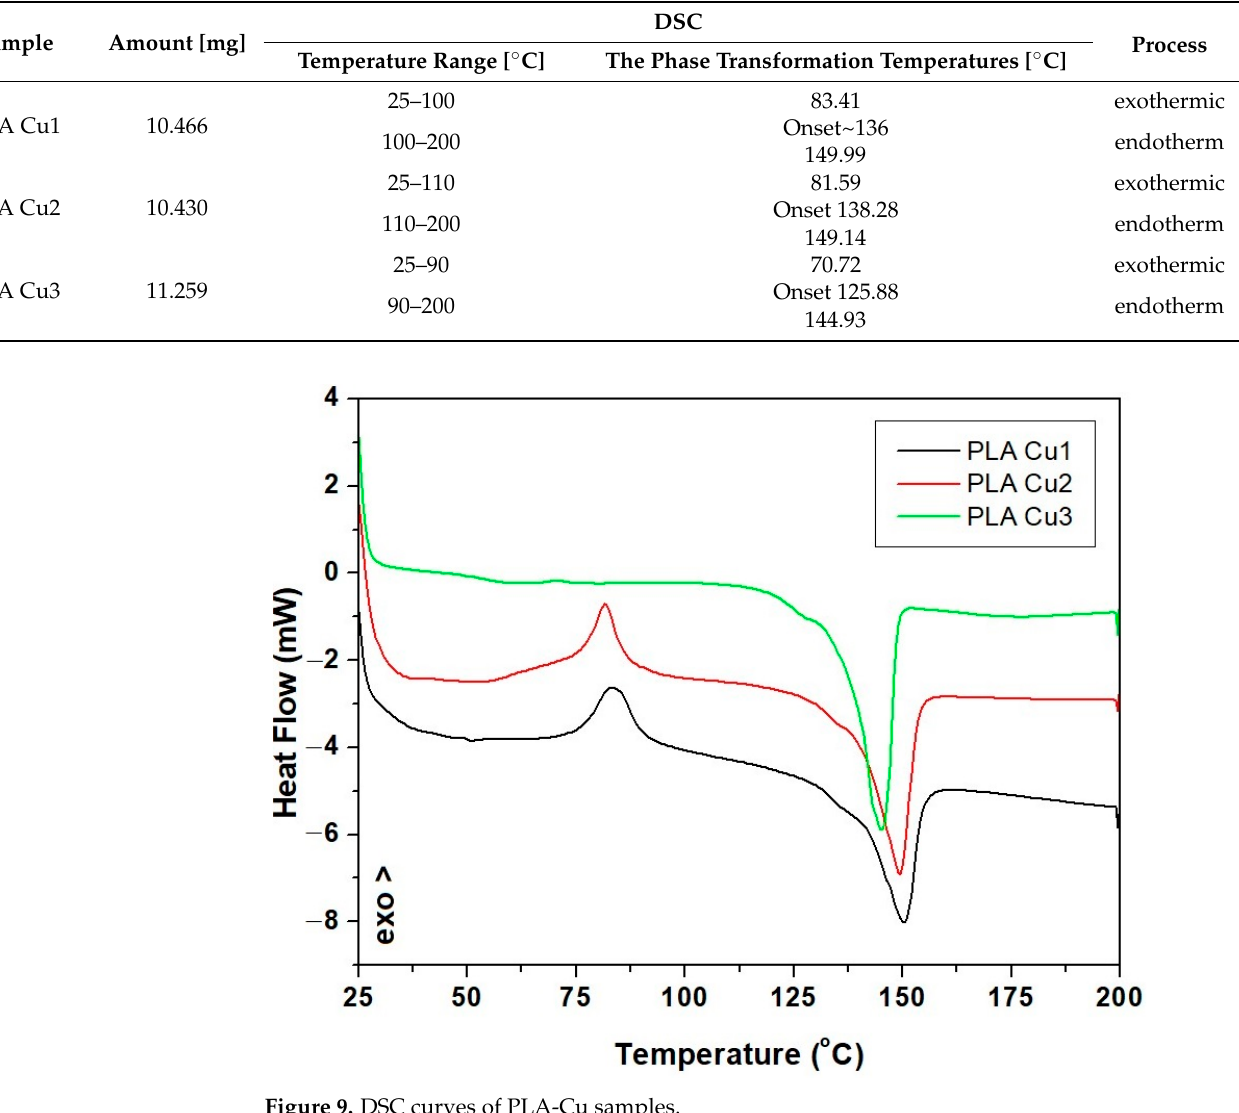
Figure 9. DSC curves of PLA-Cu samples. Table 5. The phase transformation temperatures and the identification of exothermic or endother- mic